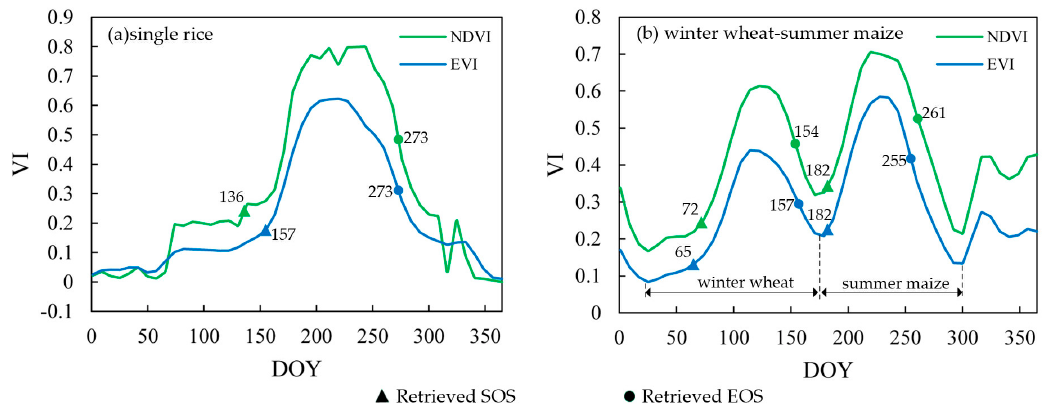
Figure 10. Differences of the retrieved the start of the season (SOS) and the end of the season (EOS) based on Normalized Difference Vegetation Index (NDVI) (in green) and Enhanced Vegetation Index (EVI) time series (in blue) with ( a ) single rice and ( b ) winter wheat-summer maize.